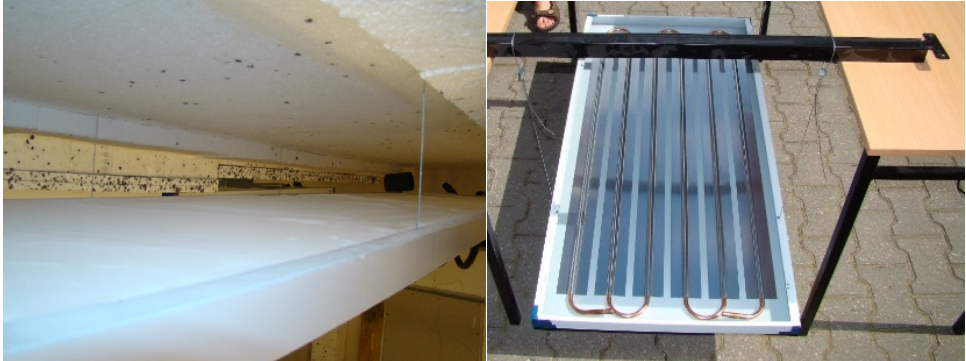
Figure 3. Thermally activated panel containing PCM [42].